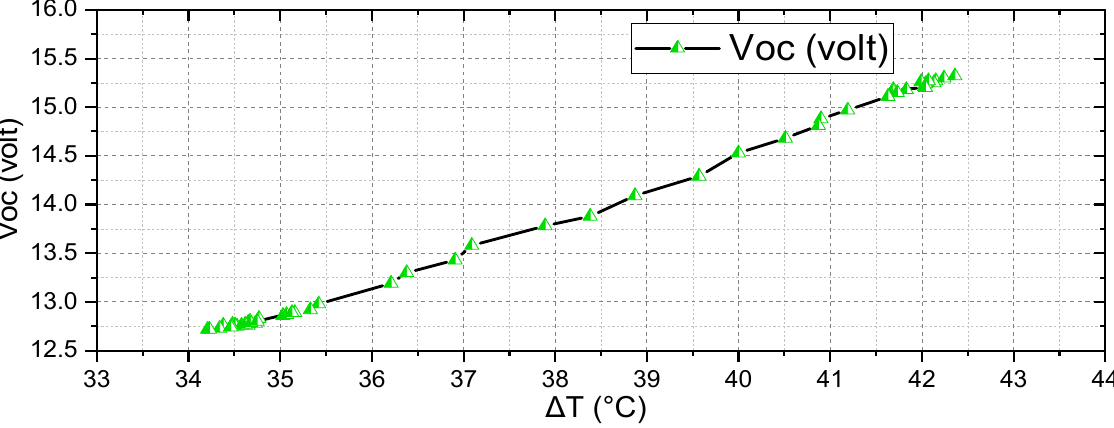
Figure 9. Δ T, 𝑇 (cid:3035) , and 𝑇 (cid:3030) of a 15 × 10 TEG Panel . Figure 9. ∆ T , T h , and T c of a 15